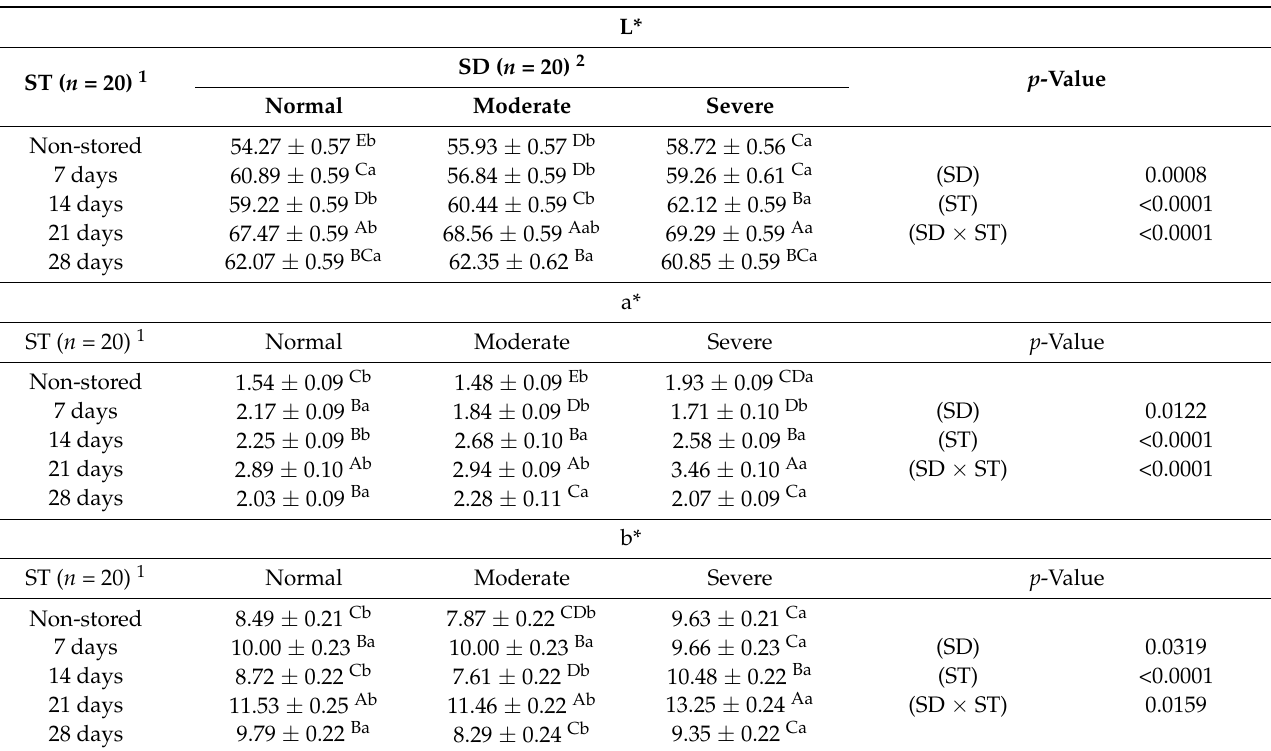
of sausages produced with breast meat, regardless of the myopathy, which decreased the pH value up to 28 days of storage. Table 4. Lightness (L*), redness (a*) and yellowness (b*) mean values in fresh sausages produced with breast meat from Ross (AP95) without myopathies and affected by wooden breast myopathy after different storage periods.